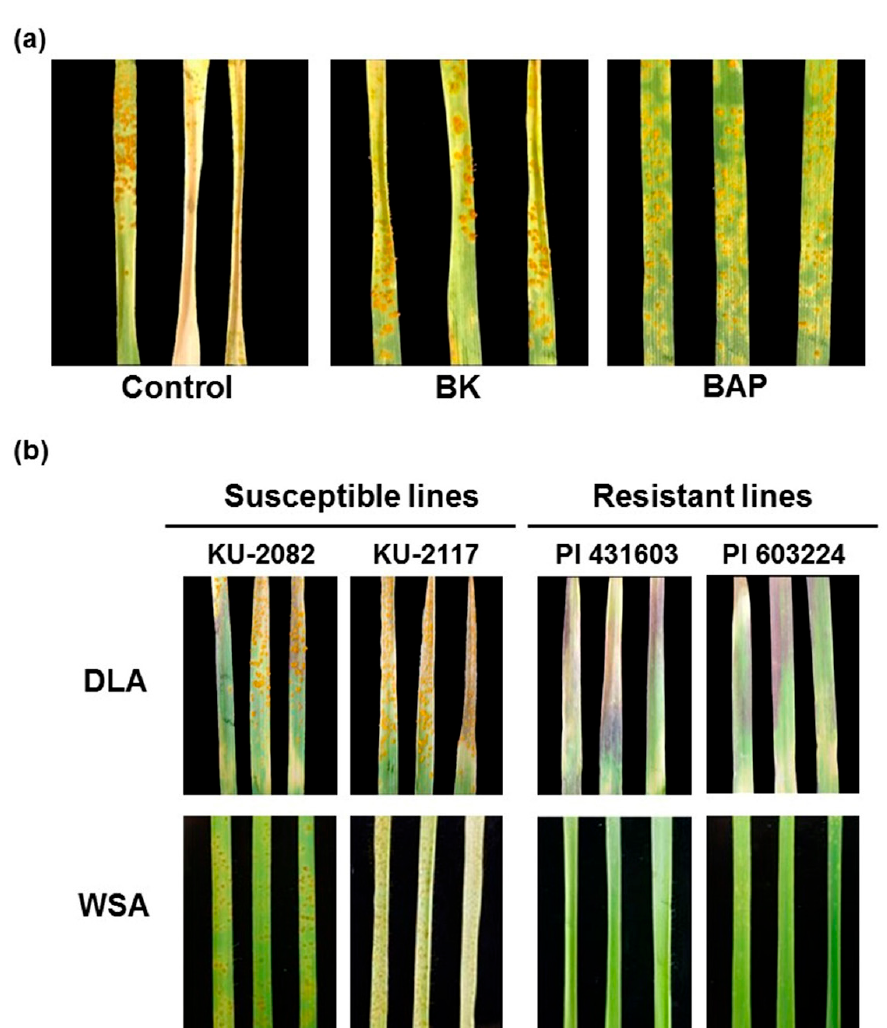
Figure 2. Pathophenotype of leaf rust on detached and undetached wheat leaves. Detached and undetached leaves of 14-days-old seedlings were grown for 10 days after inoculation with leaf rust for the DLA (detached leaf rust assay) and the WSA (whole seedling assay), respectively. ( a ) The DLA using the control, BK, or BAP medium was performed for comparing morphological variations of Keumkang wheat leaves. ( b ) The DLA using the BAP medium or the WSA was performed for comparing morphological variations of Aegilops tauschii in the greenhouse. Keumkang wheat is known to be susceptible to leaf rust. Among all Aegilops tauschii used, KU-2082 and KU-2117 are known to be susceptible, and PI 431603 and PI 603224 are known to be resistant to leaf rust.